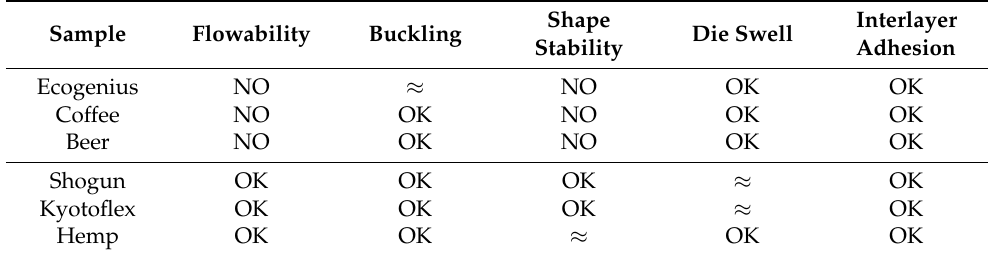
Table 3. Results of fail/pass procedure concerning the rheological characteristics of investigated filaments.